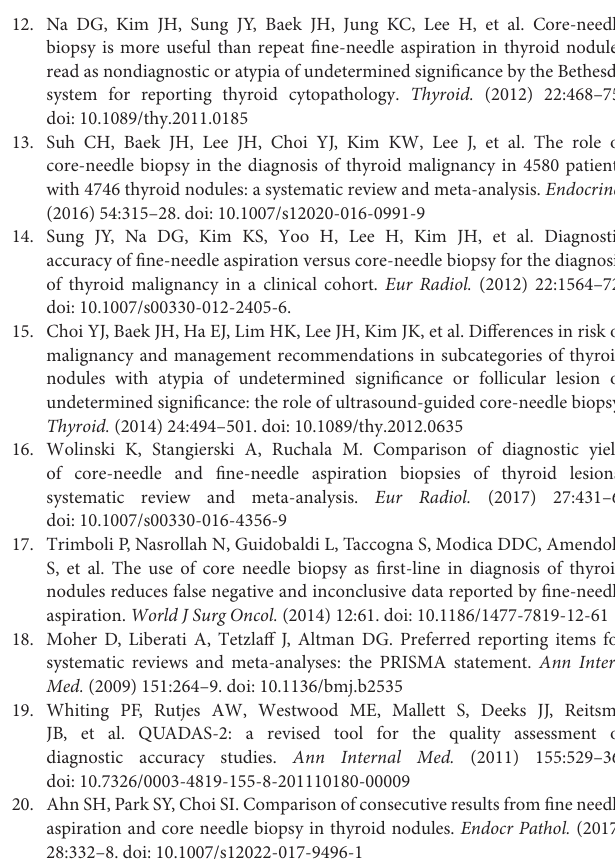
Figure S1 | Filled funnel plot of any PEP using trim-and-fill